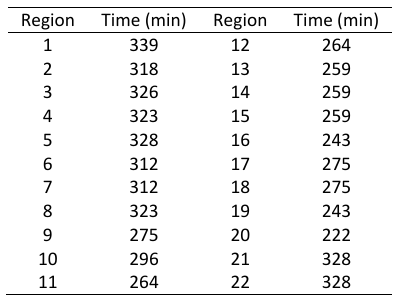
Table 5: Total time of solid waste collection and vehicle round trip to Table 5. Total time of solid waste collection and vehicle round trip waste disposal site in different district of Tehran to waste disposal site in different district of Tehran